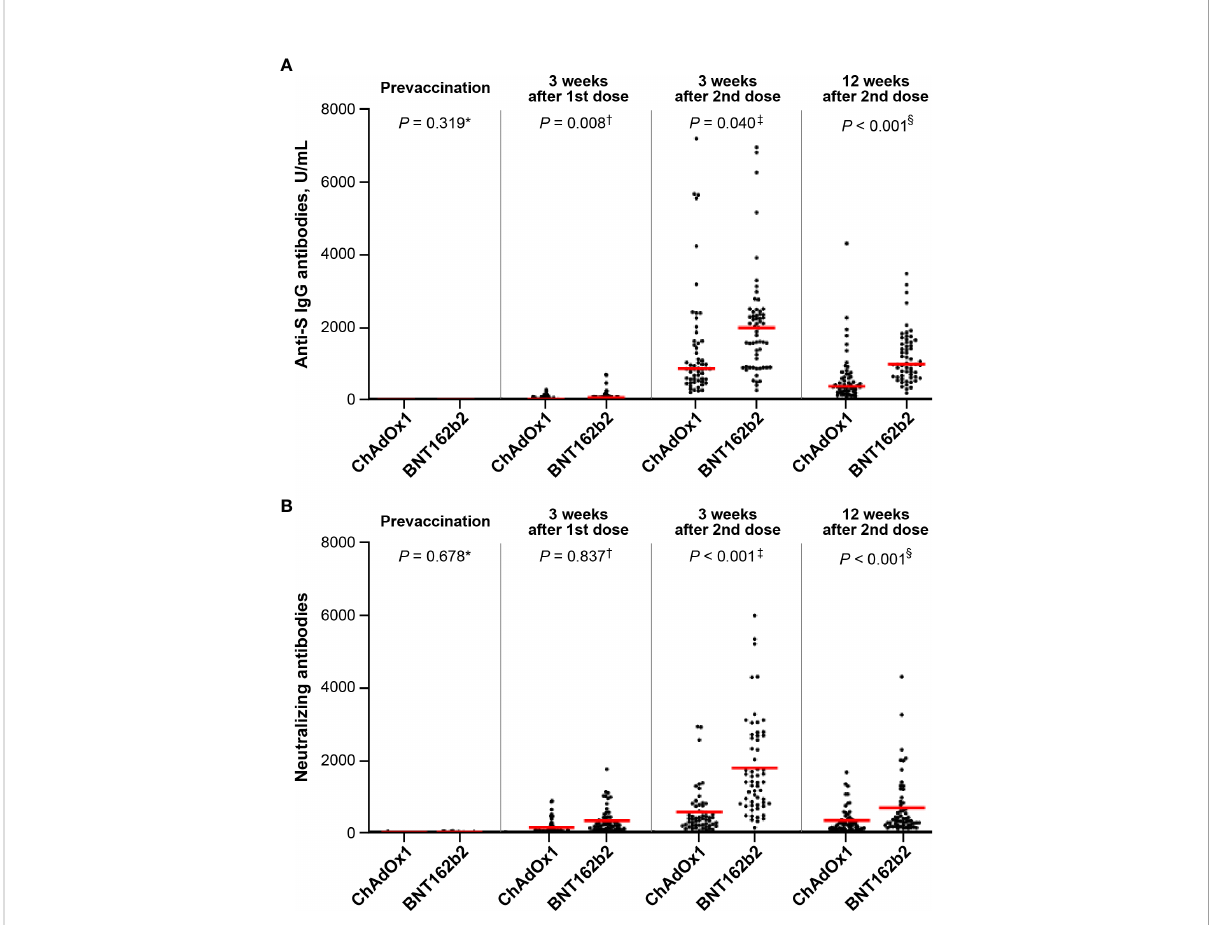
FIGURE 2 Comparison of antibody response between the ChAdOx1 nCoV-19 and BNT162b2 groups: (A) anti-S antibodies (mean ± standard deviation, U/ mL): *0 in ChAdOx1 and 0 in BNT162b2; † 50.0 ± 66.3 in ChAdOx1 and 101.5 ± 136.6 in BNT162b2; ‡ 1398.9 ± 1503.9 in ChAdOx1 and 2049.5 ± 1417.4 in BNT162b2; § 589.9 ± 679.7 in ChAdOx1 and 1171.2 ± 703.4 in BNT162b2 and (B) neutralizing antibodies (mean ± standard deviation): *15.1 ± 37.1 in ChAdOx1 and 13.6 ± 10.8 in BNT162b2; † 293.2 ± 312.4 in ChAdOx1 and 325.7 ± 442.0 in BNT162b2; ‡ 642.5 ± 812.1 in ChAdOx1 and 1786.9 ± 1322.2 in BNT162b2; § 277.8 ± 301.9 in ChAdOx1 and 684.6 ± 806.7 in